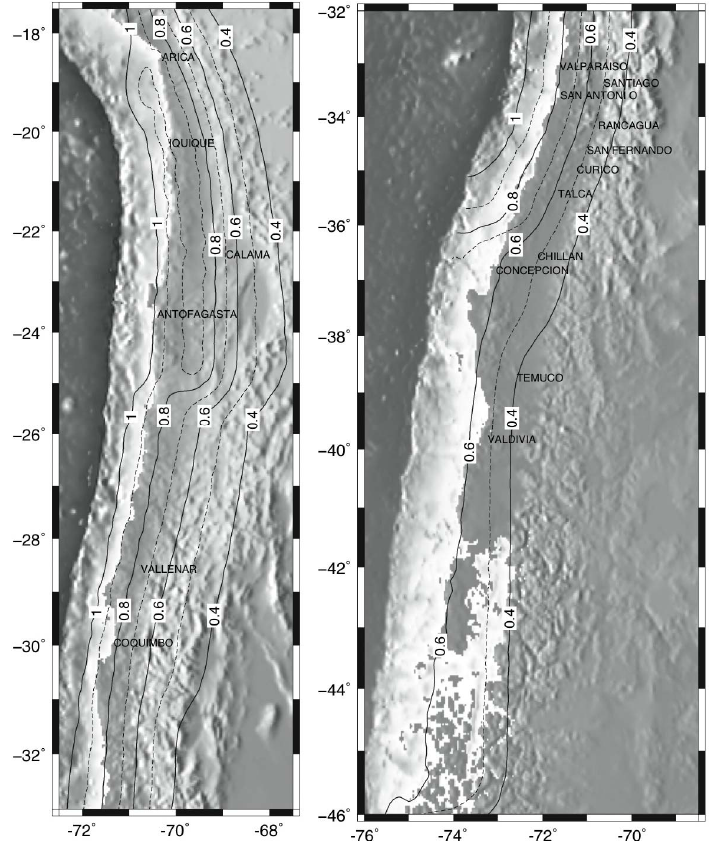
Fig. 3. Topographic map presenting contours with the horizontal peak ground acceleration (PGA), in terms of gravity acceleration (g), with a probability of 10% of being exceeded in 50 years (corresponding to 475 years return period). Table 2. Gutenberg-Richter laws (Log N= a − b M s ) for the seismo- genic zones used in this study (Z1 to